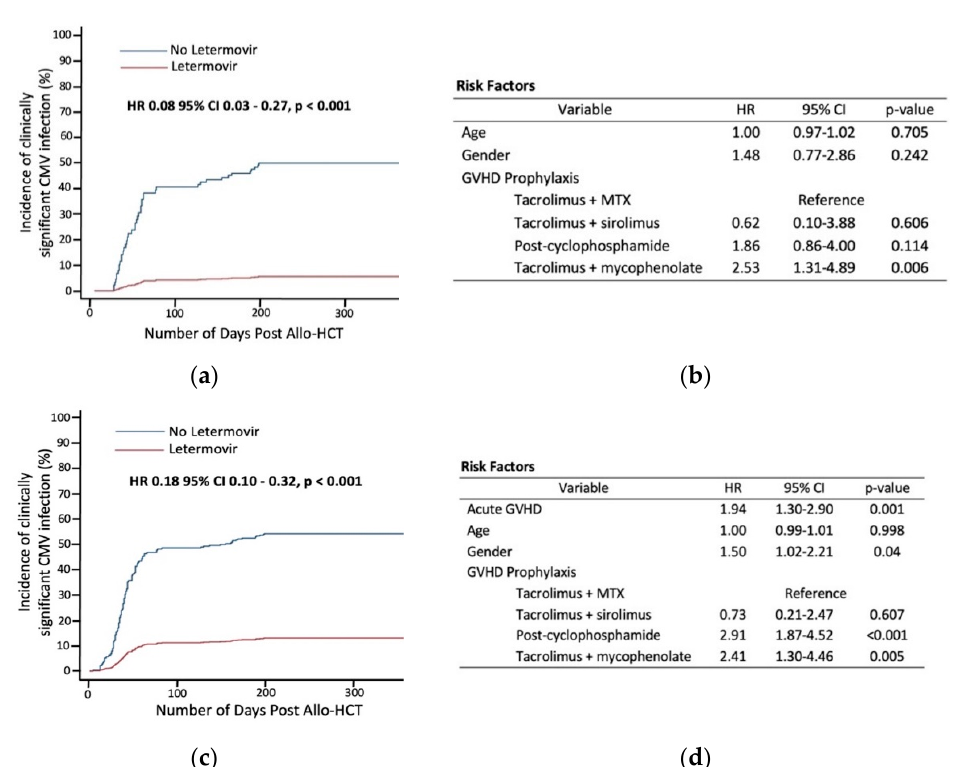
Figure 1. Incidence of clinically significant cytomegalovirus infection (CS-CMVi) in patients with and without letermovir and potential risk factors: ( a ) CS-CMVi in patients with acute graft versus host disease (aGVHD) grade ≥ 2 ; ( b ) Proportional sub-distribution hazards model of potential confounding factors in patients with aGVHD ≥ 2; ( c ) CS-CMVi in all patients; ( d ) Proportional sub-distribution hazards model of potential confounding factors in all patients.